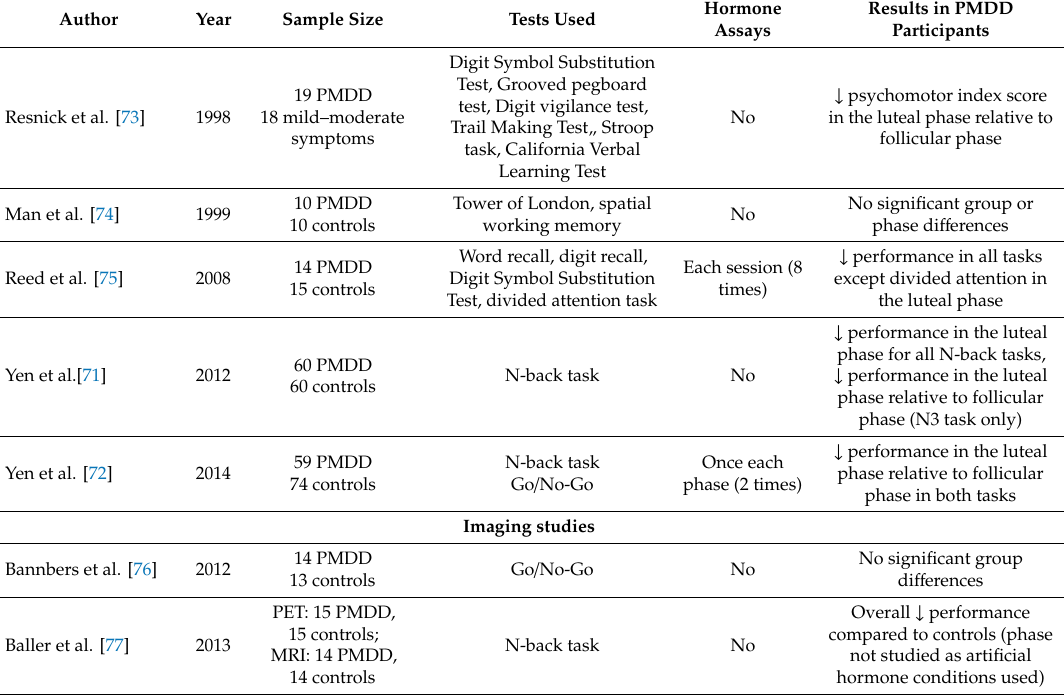
Table 2. Cognitive studies in premenstrual dysphoric disorder